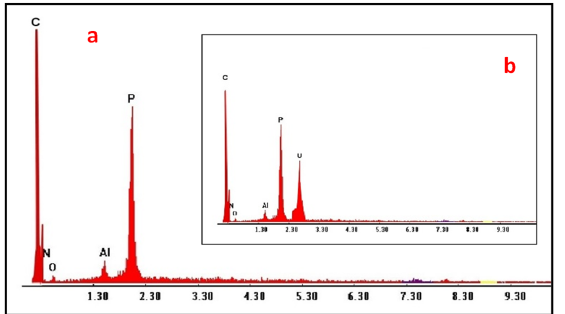
Figure 3. EDX spectra of ( a ) HTIP; ( b ) HTIP ‒ U(VI)